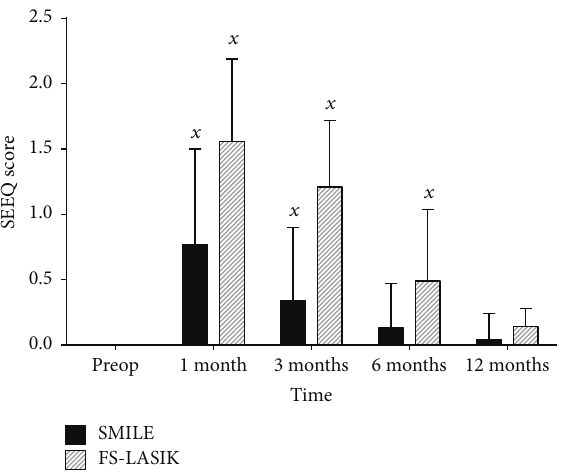
Figure 2: Salisbury Eye Evaluation Questionnaire results in SMILE and FS-LASIK groups at 1, 3, 6, and 12 months after operation. “ 𝑥 ”: statistically significantly greater than preoperative values, 𝑝 < 0.05 .